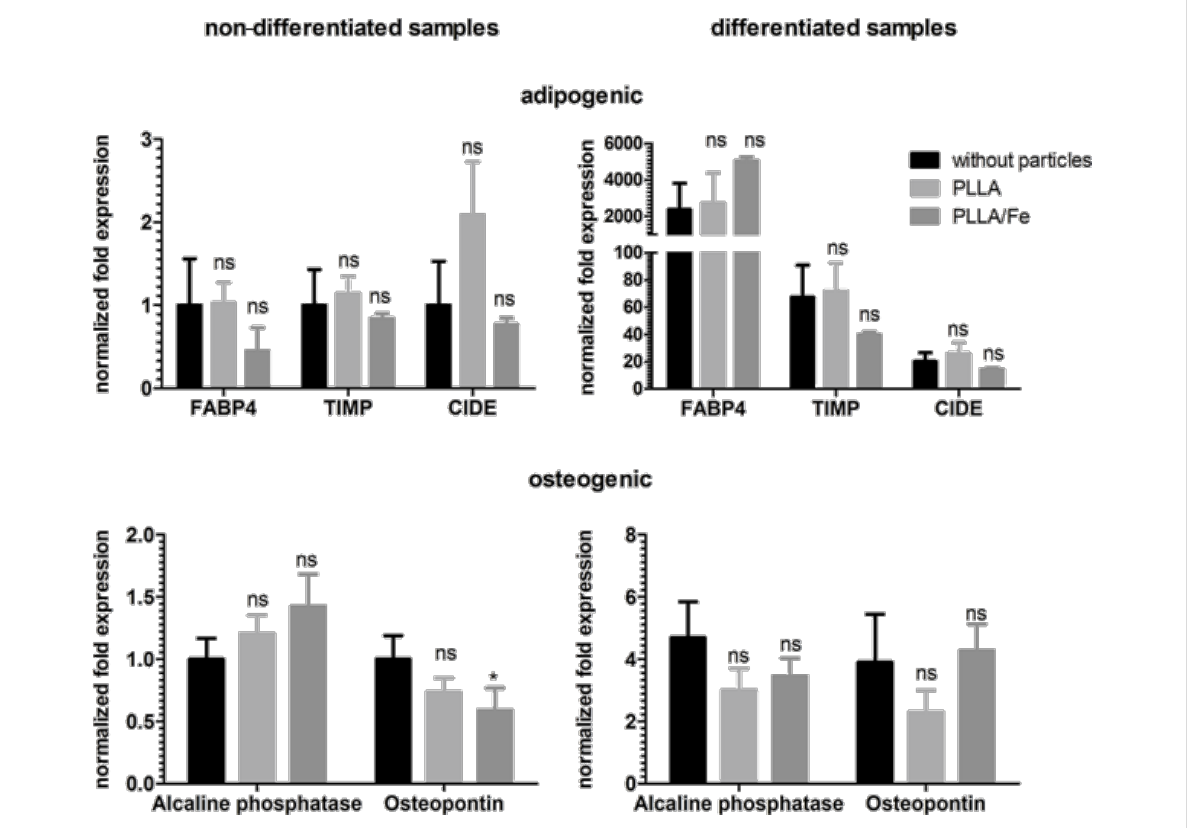
Figure 7: Influence of polylactide nanoparticles (PLLA and PLLA–Fe) on the expression of adipogenic and osteogenic marker genes in hMSCs. Expression was analyzed with qPCR, using GAPDH and B2M as internal controls. The normalized fold expression was calculated with the ΔΔ C T method, assigning the non-differentiated sample without nanoparticles as a control. p > 0.05 ns, p < 0.05 *.